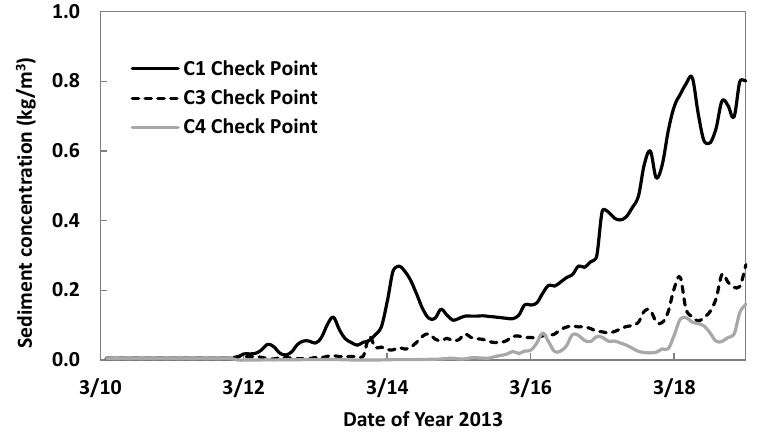
Figure 12. Time series of SS concentrations at check points C1, C3 and C4.